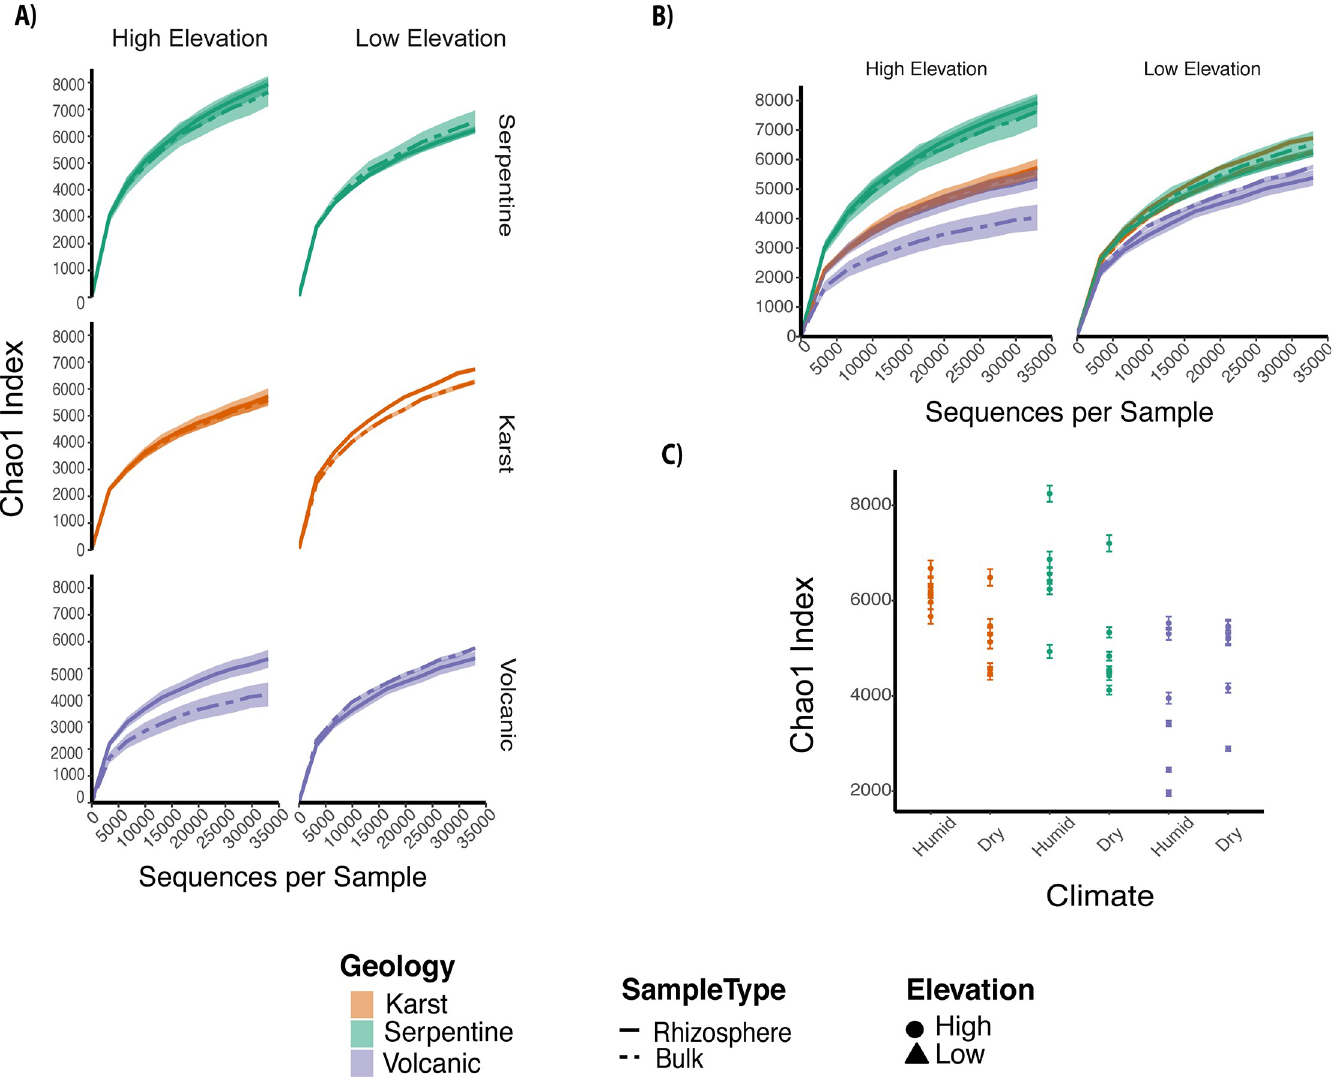
Fig 2. Alpha diversity plots depicting richness estimations. Panel A shows rarefaction curves of rhizosphere and soil microbial communities for each of three parent materials. Panels are organized from sites with highest to the lowest number of OTUs (serpentine to volcanic) and columns show sites with high and low elevation. Curves were constructed using Chao1 index for samples with up to 30,170 reads. Bars reflect the 95% confidence intervals. Panel B depict rarefaction curves organized by elevation, whereas in panel C samples are color coded by geology while x-axis corresponds to humid and dry climate for each of the three geologies.